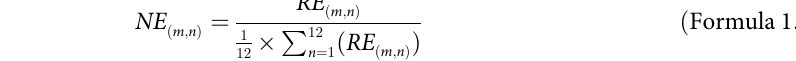
ð Formula 1 : 1 Þ